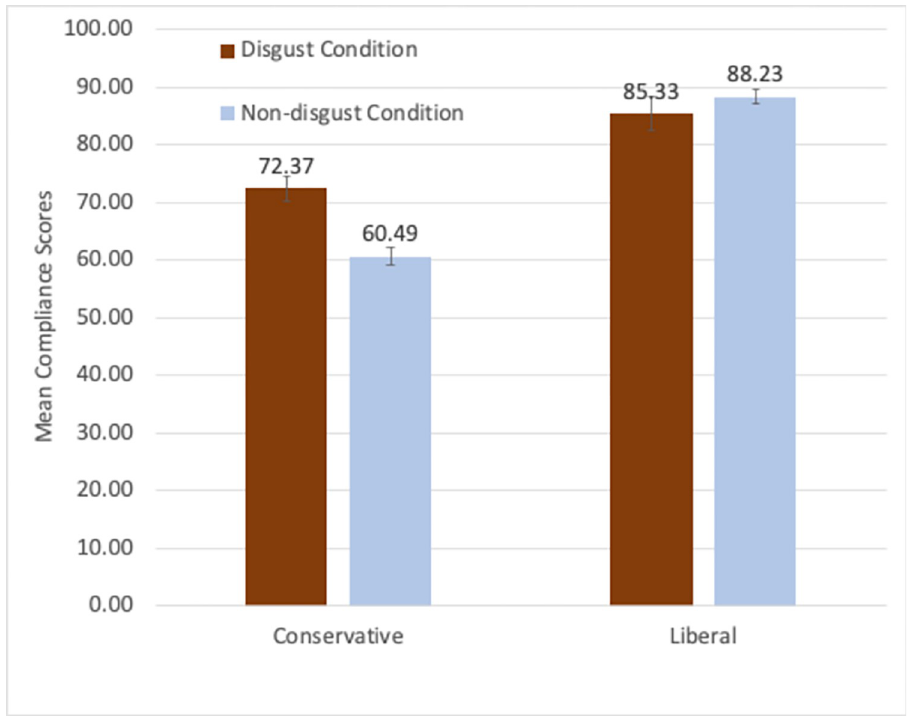
virus. Thus, the composite measures would be a better index for the public health compliance rather than each individual measure. Next, we tested whether the compliance scores were higher in the disgust condition than in the non-disgust condition, and whether this effect differed between conservative and liberal participants. The means of the four conditions are shown in Fig 1. A 2 (condition: disgust vs. non-disgust) X 2 (political orientation: liberal vs. conservative) ANOVA was carried out on these compliance scores. There was a significant main effect of political orientation: liberals’ compliance scores ( M = 86.79, SD = 14.17) were significantly higher than conservatives’ ( M = 66.42, SD = 23.81), F (1, 374) = 110.19, p < .001, partial η 2 = .23. The compliance scores of the disgust condition ( M = 79.71, SD = 18.93) were significantly higher than those of the non-disgust condition ( M = 76.12, SD = 23.64), F (1, 374) = 5.19, p = .023, partial η 2 = .014, but